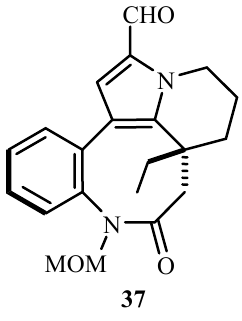
Figure 5. MOM-Rhazinal (MOM: Methoxymethyl Figure 5. MOM ‐ Rhazinal (MOM: Methoxymethyl ether).